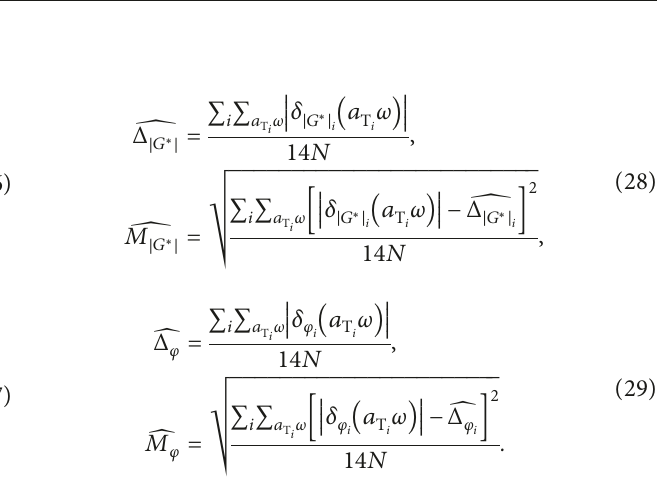
and G ( Δ G and Δ G , respectively); (b) relative error for | G ∗ | ( Δ | G ∗ | 1 2 1 i 2 i